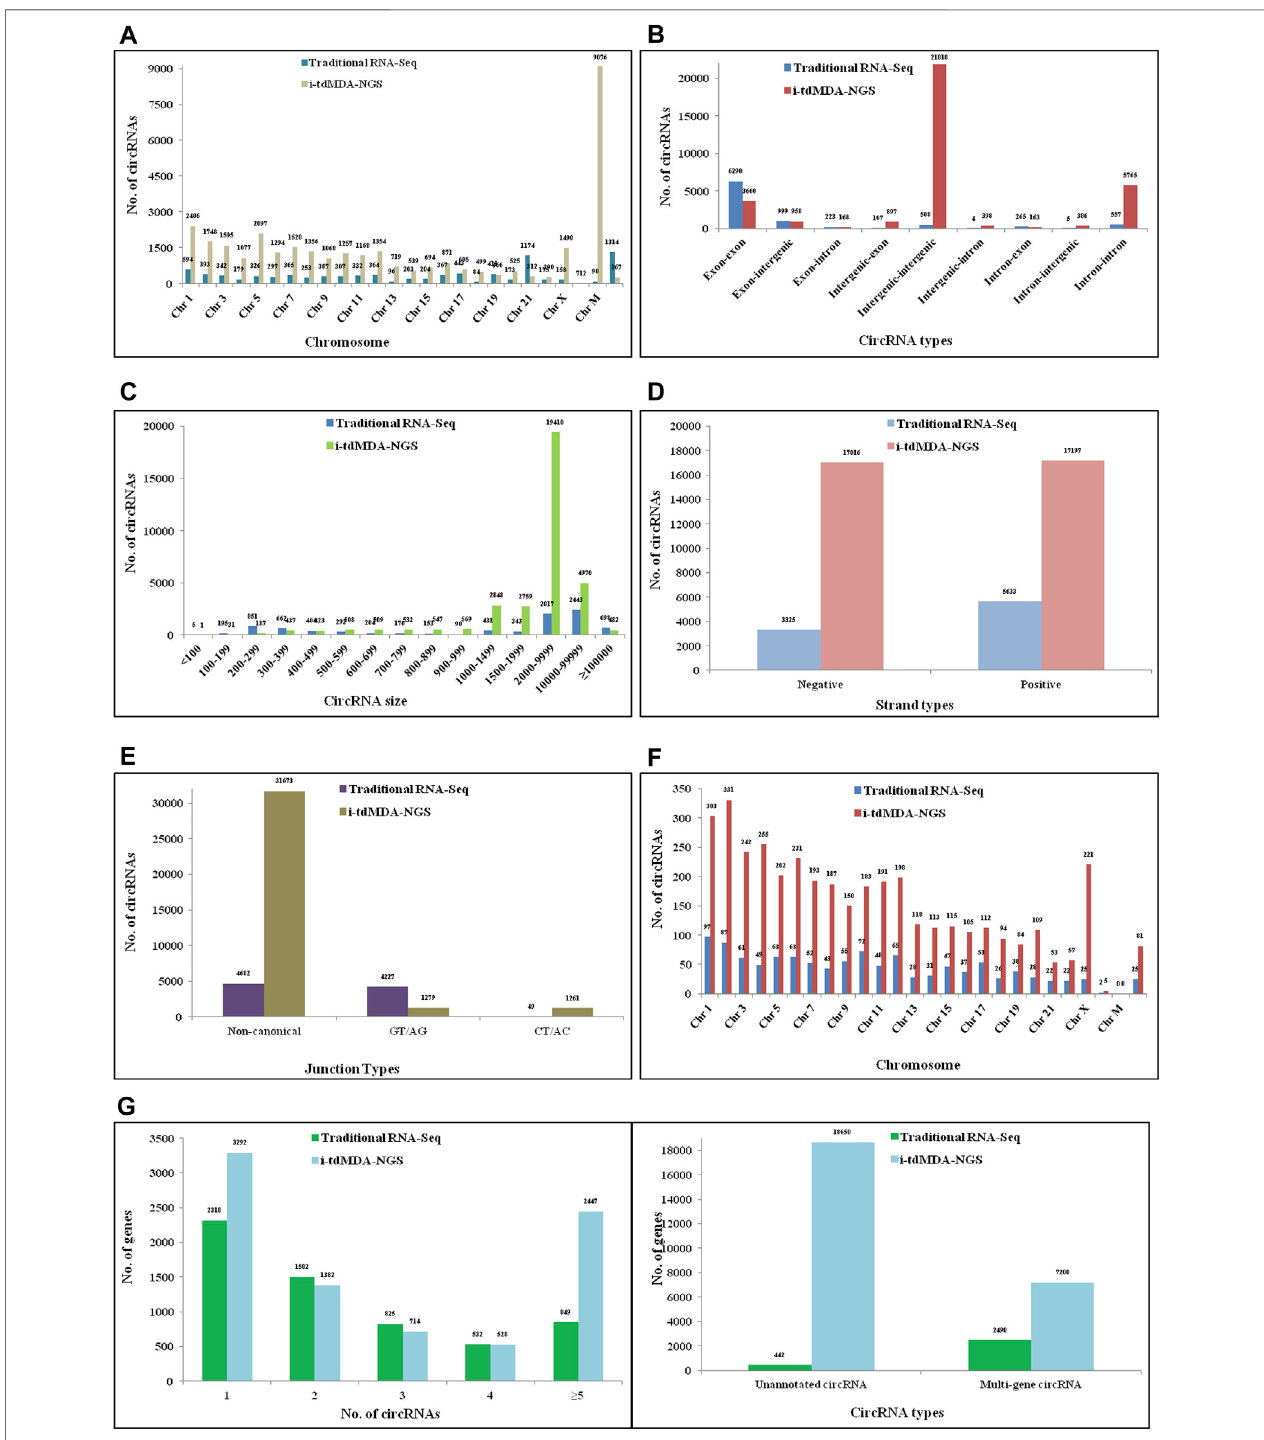
FIGURE 3 | Comparative analysis of rice circRNAs by DCC. Rice circRNAs identi fi ed by traditional circRNA-Seq and i-tdMDA-NGS were analyzed by the DCC computational pipeline and compared based on its (A) location on the chromosome, (B) types, (C) size, (D) strand location, and (E) junction types; (F) expression of circRNAs over the corresponding linear RNA across chromosomes, and (G) number of circRNAs per host gene.